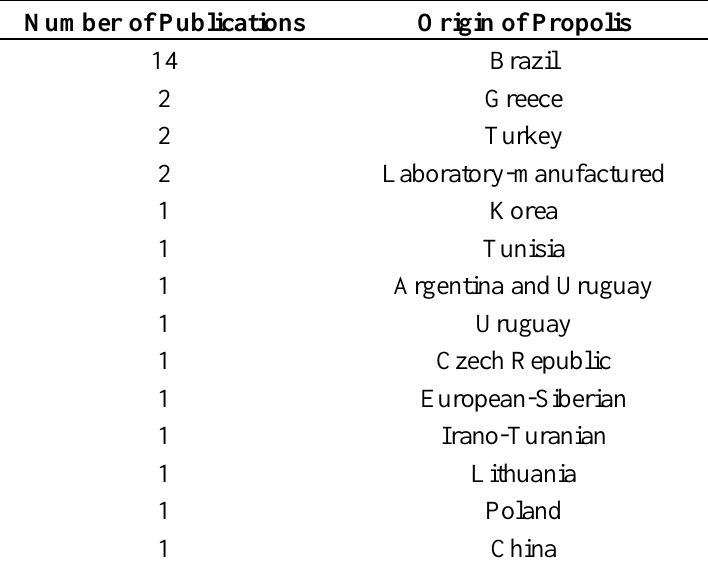
Table 4. Geographic origin of